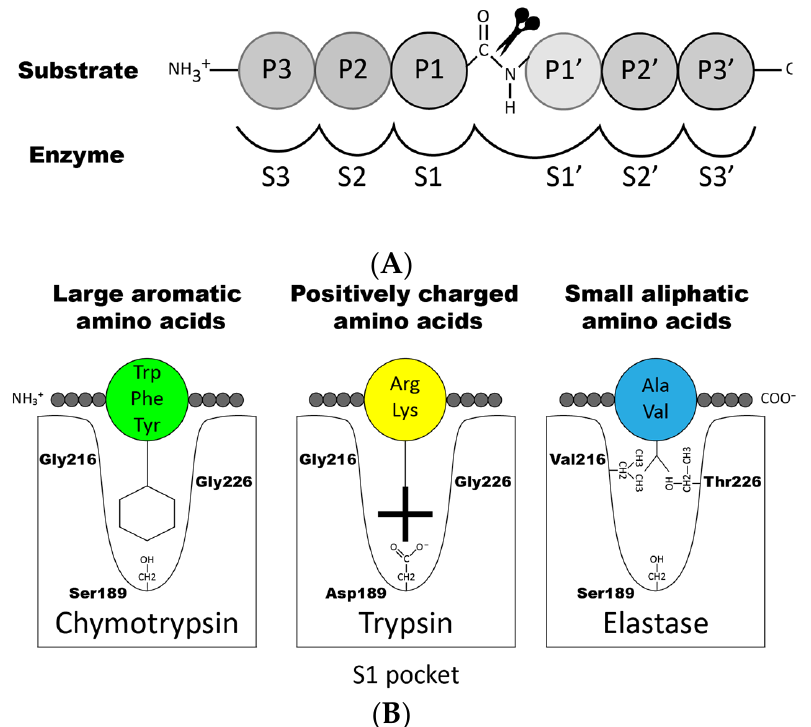
Figure 3. Nomenclature surrounding the cleaved peptide bond. ( A ) shows the amino acids N-terminal from the cleaved bond that are termed P1 (where cleavage occurs, depicted by scissors), P2, P3 etc. Amino acids C-terminal of the cleaved bond are termed P1’ (adjacent to P1), P2’, P3’ etc. The corresponding interacting sub-sites in the enzyme are denoted with S. ( B ) shows the S1 pocket, which is important in determining the primary specificity of the chymotrypsin family. The important residues are shown, which determine chymotrypsin-, trypsin- or elastase-like specificity. The figure is a modified and combined version of figures 6 and 7B from Hellman and Thorpe 2014 [14].